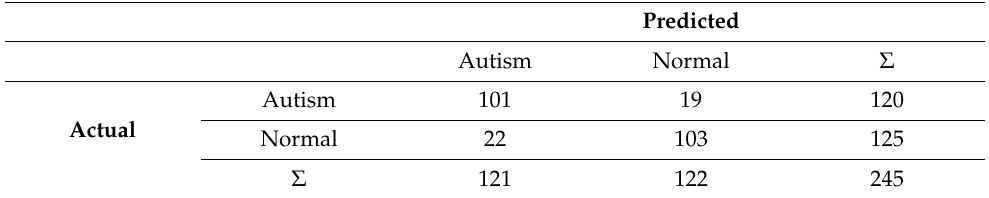
Table A2. Confusion matrix from Exp-5. Exp-5 repeated Exp-3 with the Kaggle dataset replaced with the cleaned Kaggle dataset described in Section 3.2.2.